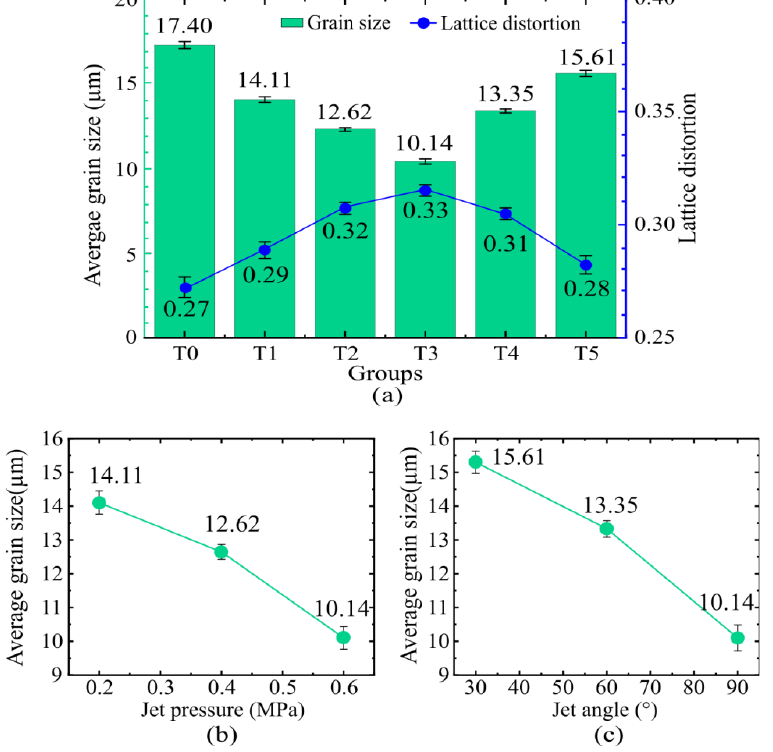
Figure 7. ( a ) The average grain size and lattice distortion of specimens; ( b ) Variation of average grain size with jet pressure; ( c ) Variation of average grain size with jet angle.